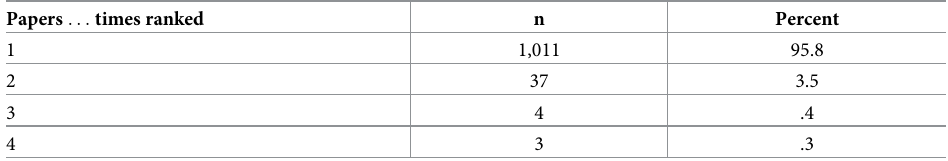
Table 2. Number of rankings of single papers. Papers ... times ranked